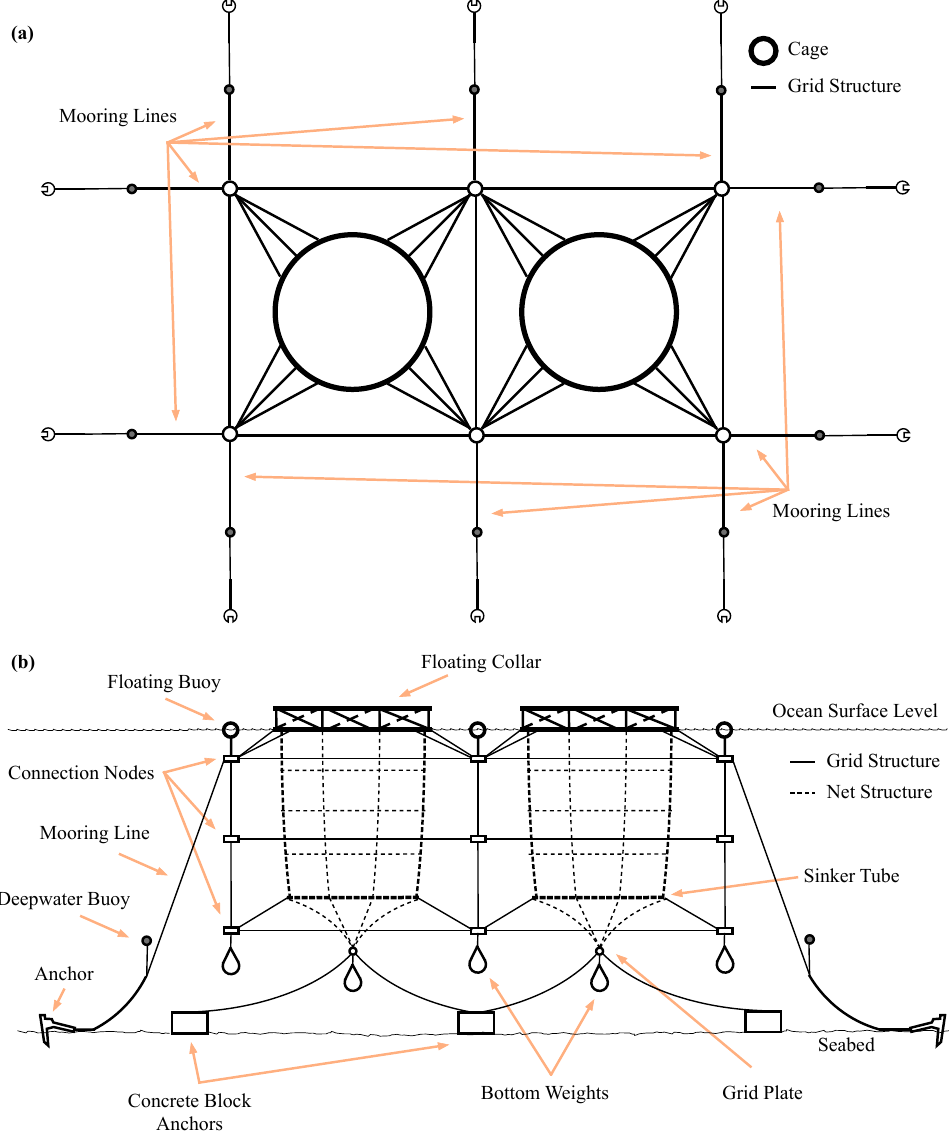
Figure 1. Example of a floating fish farm structure. Top ( a ) and front ( b ) views for a 2 × 1 Grid